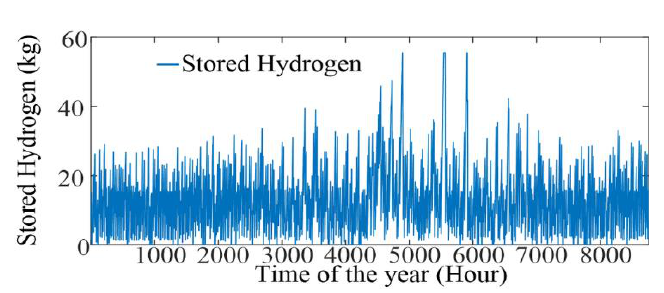
Figure 17. Hydrogen production over the year: combination 4.